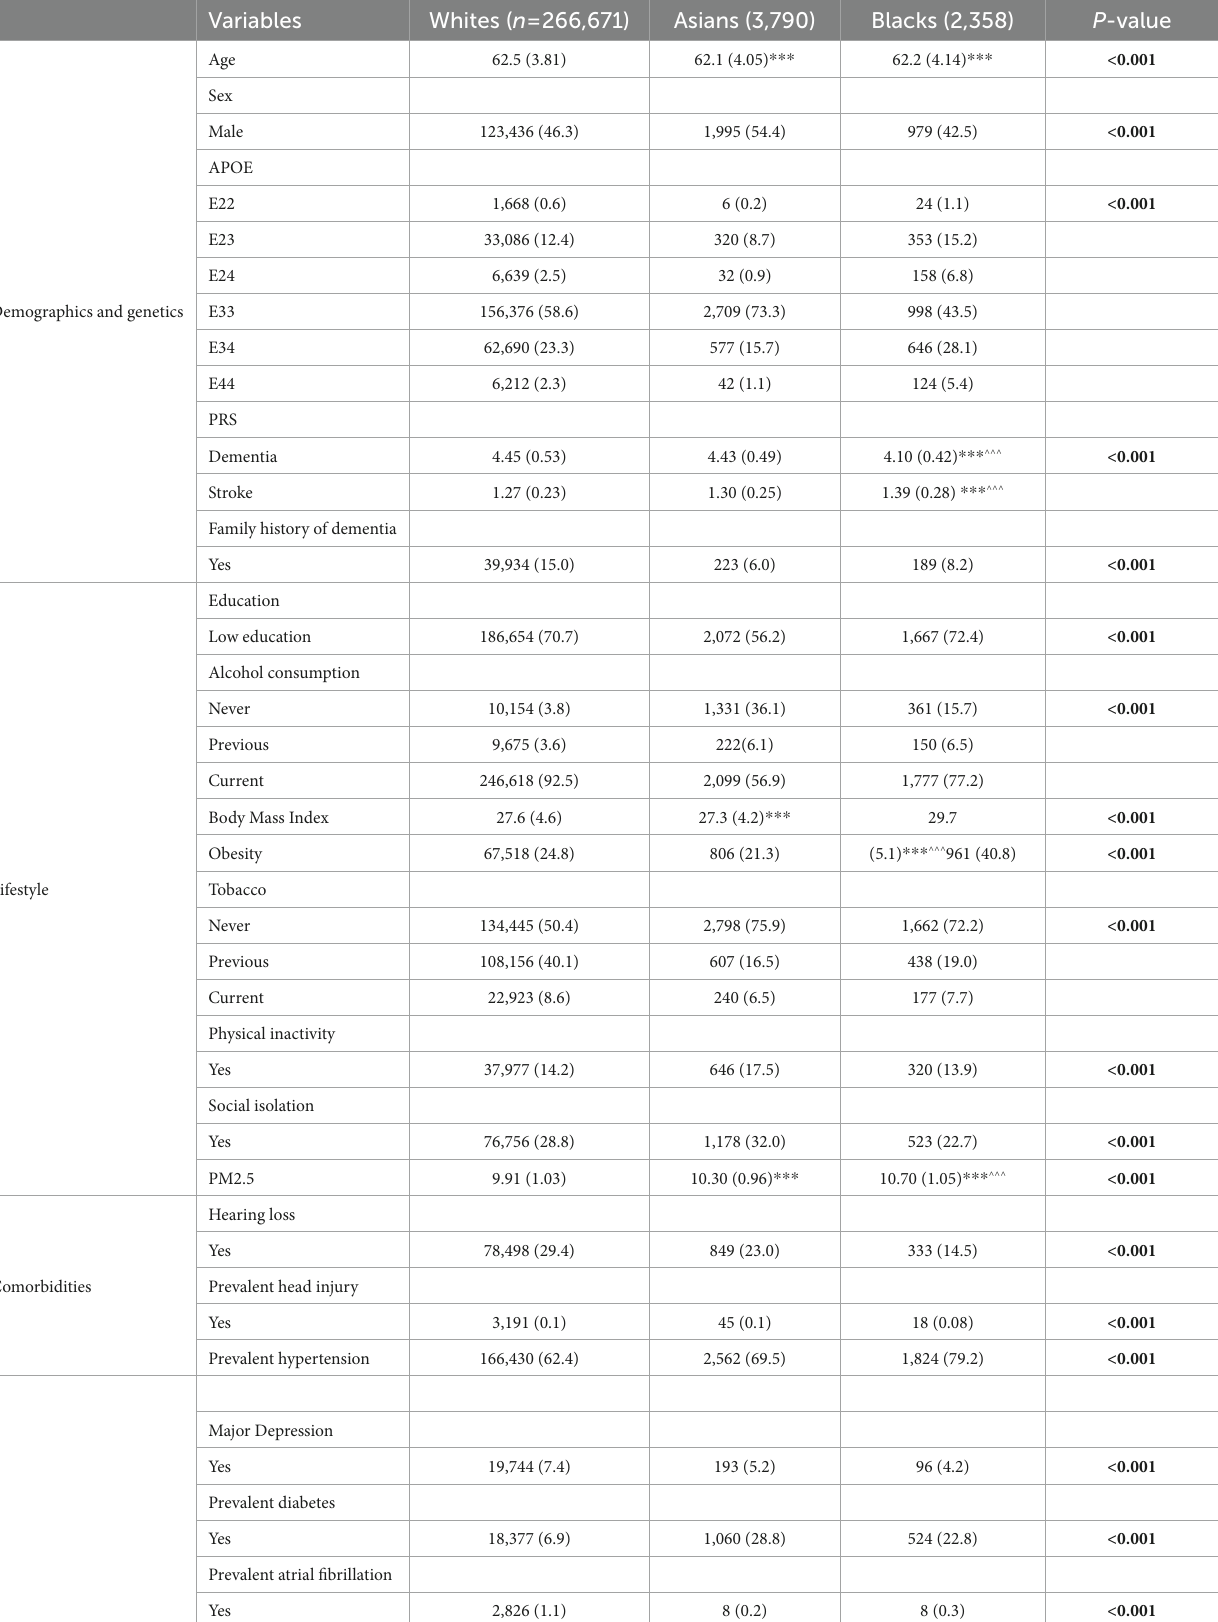
TABLE 1 Characteristics of the participants at the inclusion, mean (standard deviation) and number (%) according to the type of variables.